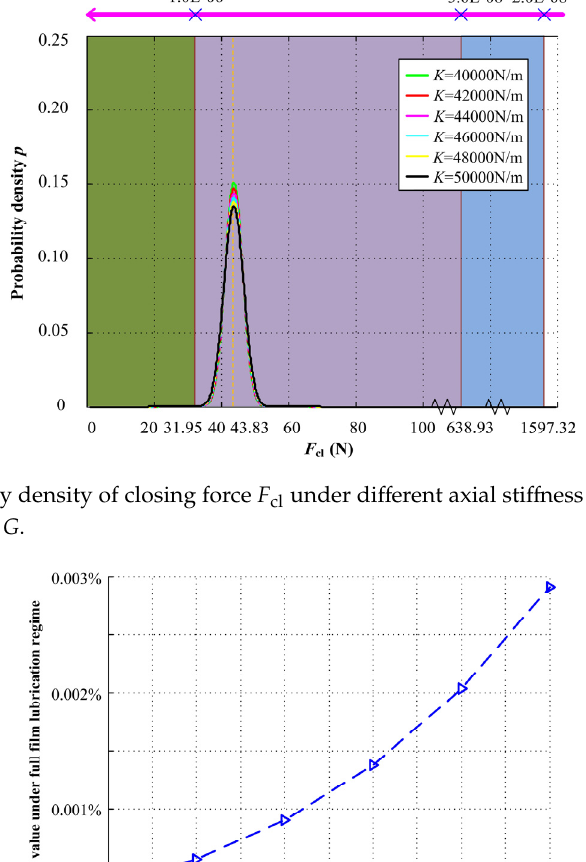
Figure 11. Probability value under different axial damping.